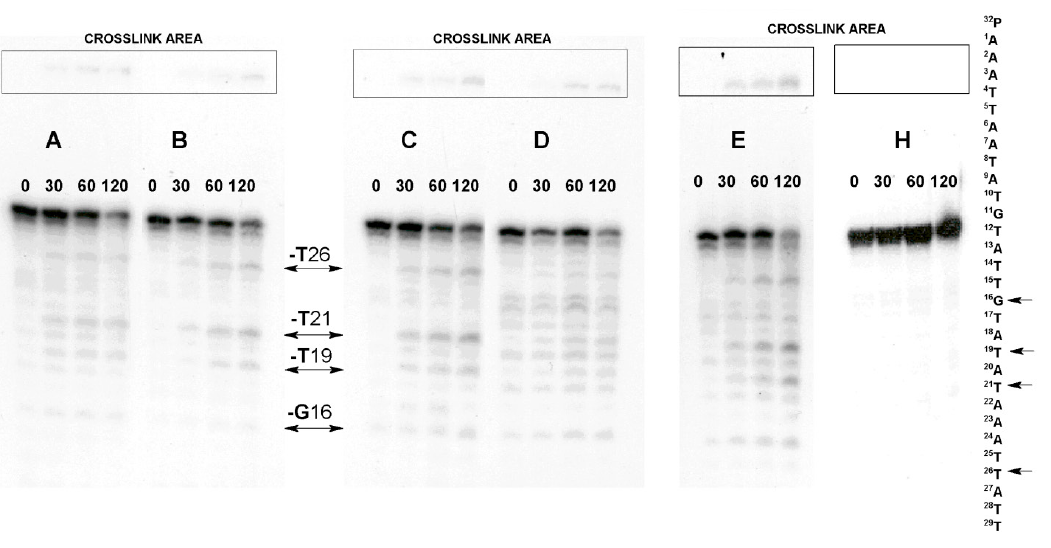
Figure 4: Autoradiogram of the results of irradiation of AQ-linked ds -DNA: A–H, indicating the positions of the main lesions after piperidine treatment. Radiation time is given in